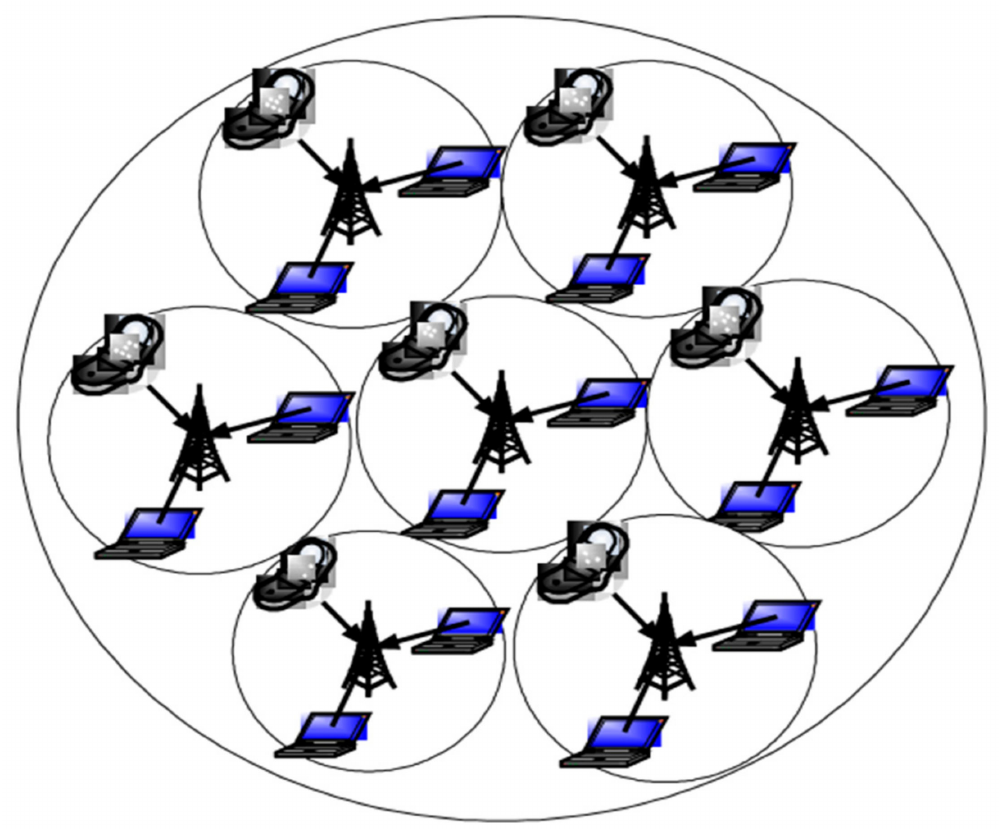
Figure 4. Femtocell: Consumer installed wireless data access points inside